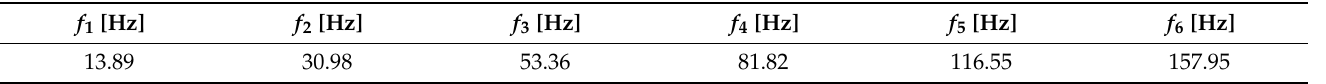
Table 4. Tie-rod eigenfrequencies of the first six bending vertical modes, identified after the tension- ing